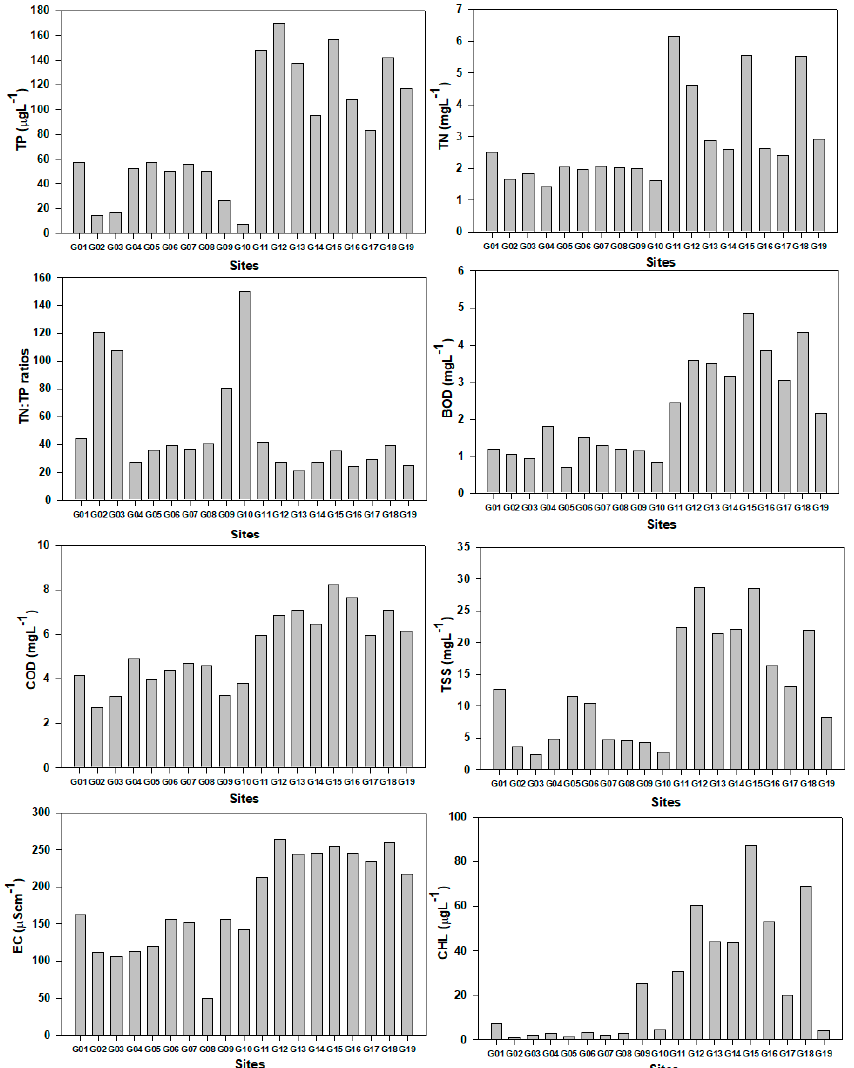
Figure 2. Variation of water quality parameters on the basis of sites in the Geum River watershed.